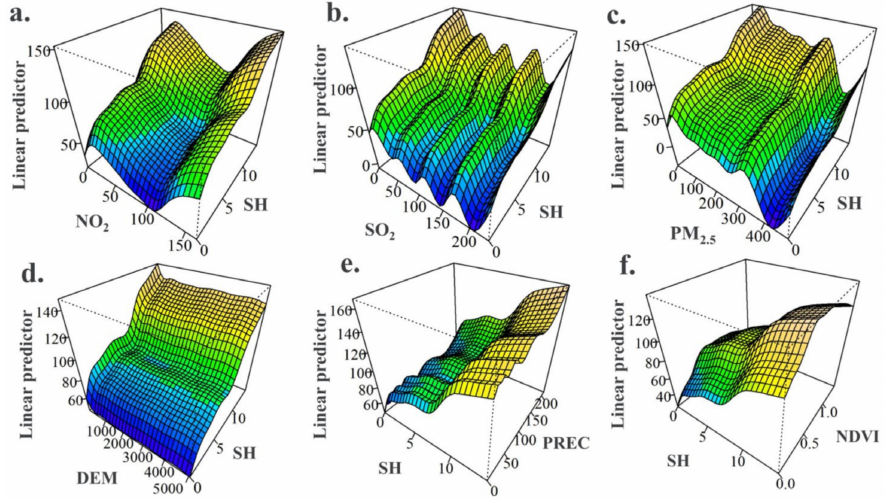
Figure 7. Interaction of different factors on the variation of urban O 3 concentration Three-dimensional effect plots. ( a ) NO 2 and sunshine hours (SH); ( b ) SO 2 and sunshine hours (SH); ( c ) PM 2.5 and sunshine hours (SH); ( d ) Digital Elevation Model (DEM) and sunshine hours (SH); ( e ) precipitation (PREC) and sunshine hours (SH); ( f ) normalized difference vegetation index (NDVI) and sunshine hours